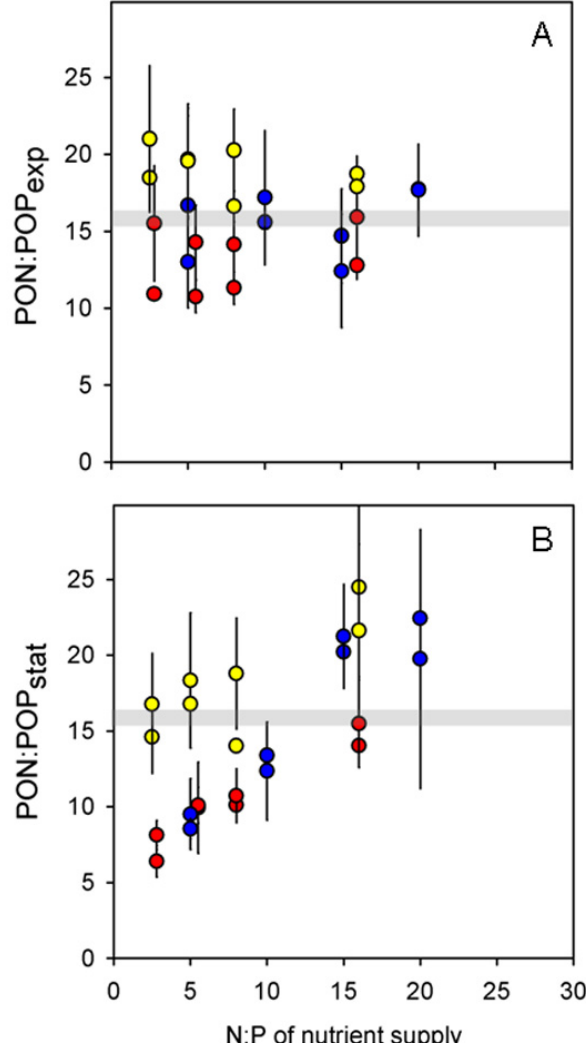
Fig. 7. PON : POP stoichiometry during (A) exponential and (B) stationary growth phase. Greyish bars signify the N : P Redfield ra- tio of 16 : 1. Style and colour-coding according to Fig.